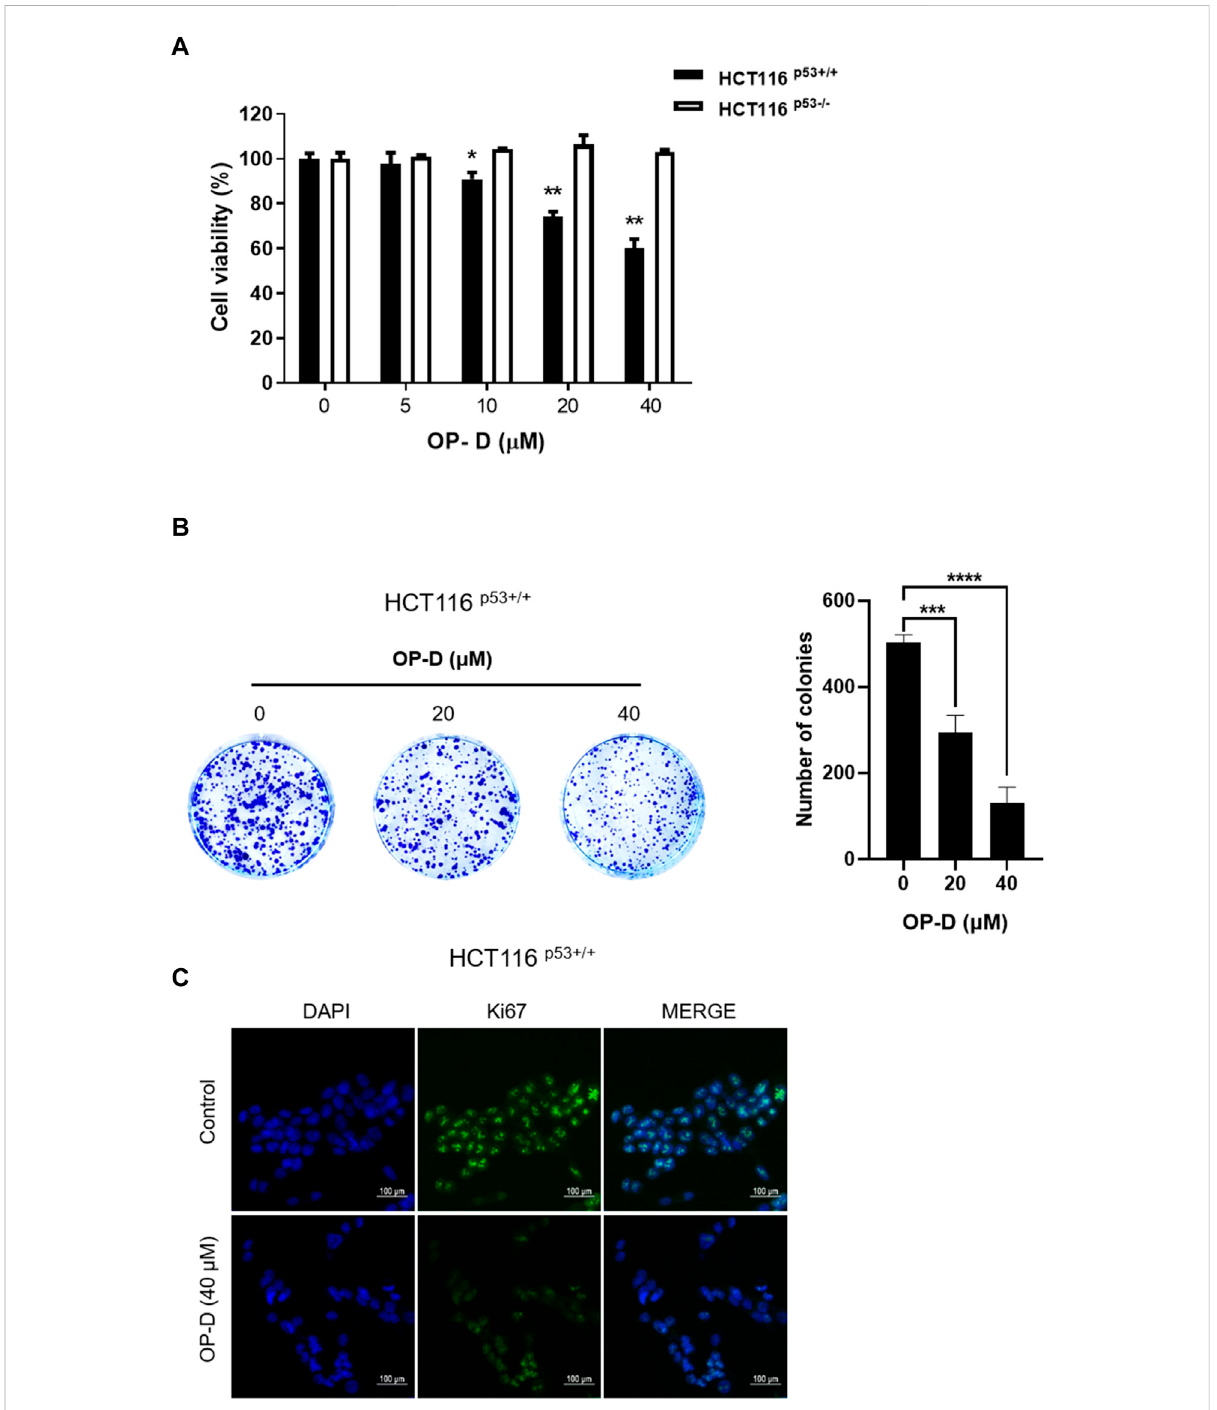
FIGURE 1 OP-D inhibited the viability and proliferation of colon cancer cells. (A) OP-D affects cytotoxicity in HCT116 p53+/+ and HCT116 p53 − / − cells. Cells were seeded inthe 96 well plates and treated with 5, 10,20, or 40 μ M ofOP-D for 24 h. Cytotoxicity wasdetermined by CCK8 assay. Data represent means±SD.* p < 0.05,** p < 0.01 versus untreatedcontrol. (B) Colonyformationimage(right fi gure)andabargraph(left fi gure)inHCT116 p53+/+ cells. Data represent means ± SD. *** p < 0.005, **** p < 0.001 versus untreated control. (C) HCT116 p53+/+ cells were treated with OP-D (40 μ M) for 24 h. Then, cells were fi xed with 4% paraformaldehyde and stained with Ki67 antibody. Images are magni fi cation ×200, scale bar 100